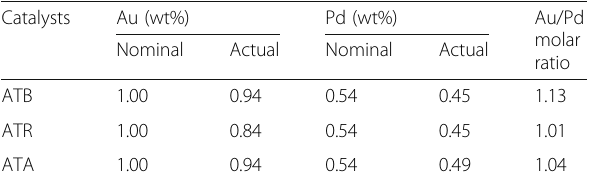
Table 1 Au and Pd bulk composition on the Au-Pd/TiO 2